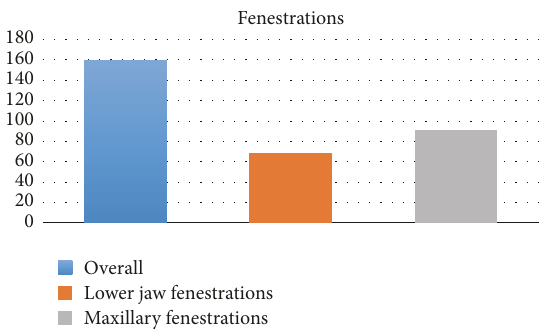
Figure 2: Incidence of fenestrations in maxilla and in